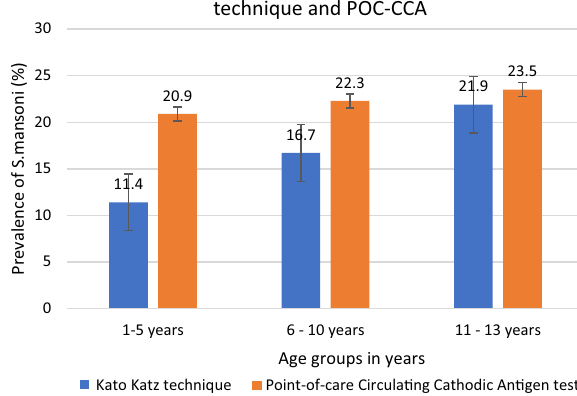
Figure 2. Prevalence of S. mansoni based on Kato Katz technique and Point-of-Care Circulating Cathodic Antigen rapid test among pre-school and school aged children in villages surrounding Lake Nyasa, Southern